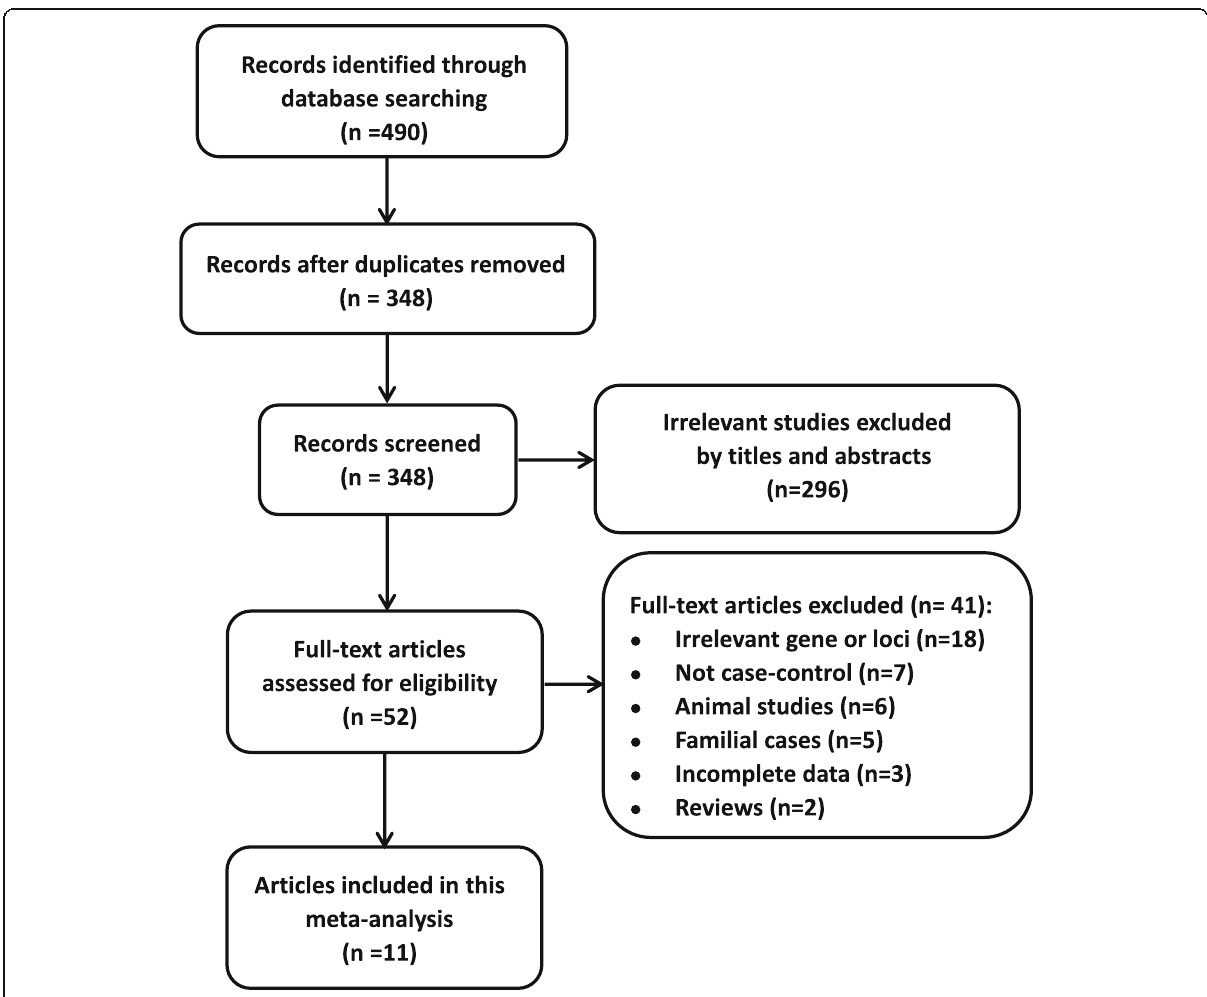
Fig. 1 Flow chart of study selection. Ultimately, 11 articles were